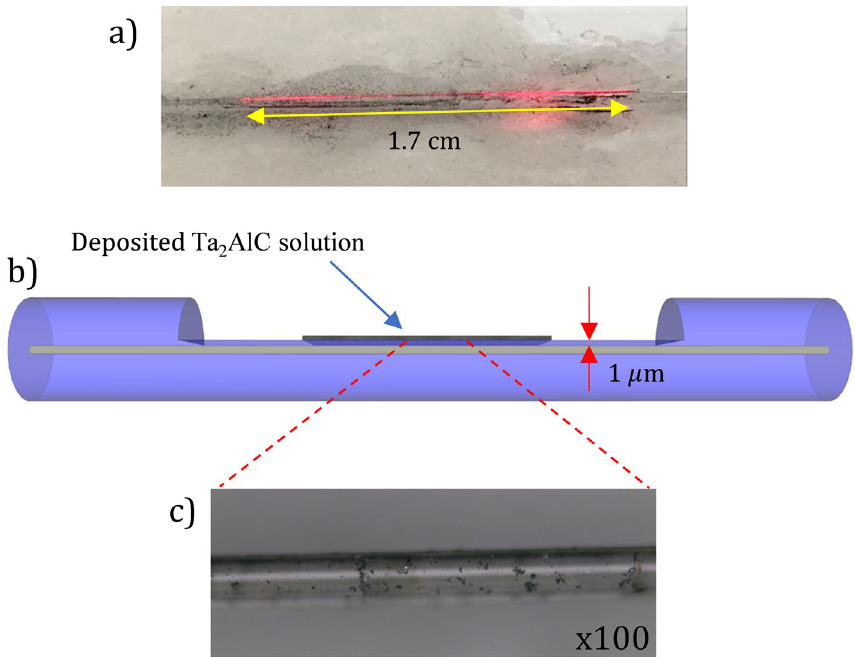
Figure 6. ( a ) The evanescent field at the polished region using a red-light source. ( b ) The deposited Ta 2 AlC on the SPF. ( c ) Microscopic image of the polished part of the side polished fiber at ×100